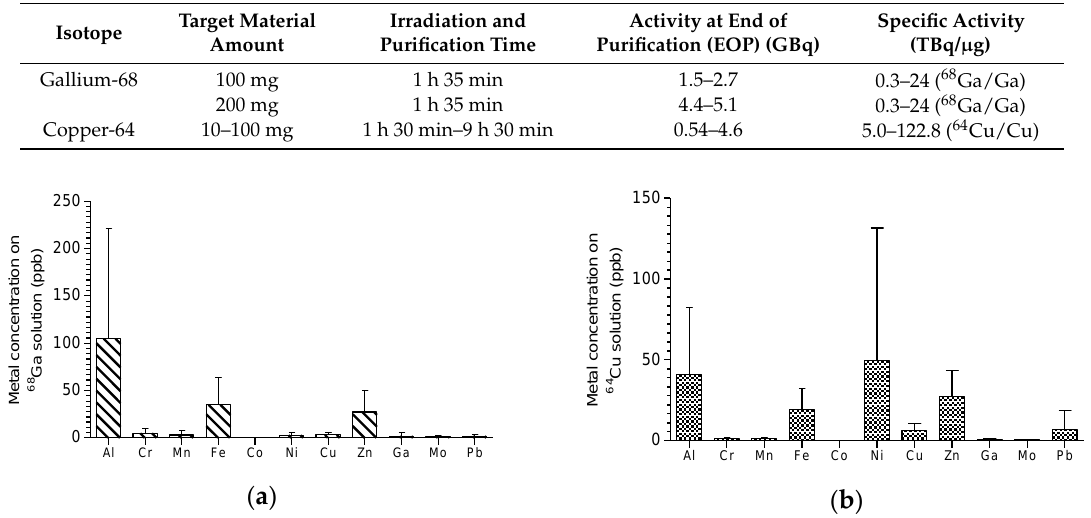
Figure 4. Concentration of Ga, 64 Cu and other contaminants in the final product solution. Final volume: 10 mL for Ga and 4 mL for Cu. (number of values n = 25 for Ga ( a ) and n = 3 for Cu ( b )). 68 Ga solutions produced were tested for the presence of iron and zinc using ICP-MS. Results are shown in Figure 5 and are in accordance with the Ph. Eur. requirement of a maximum of 10 μg/GBq [14] up to 4 h after the end of purification.